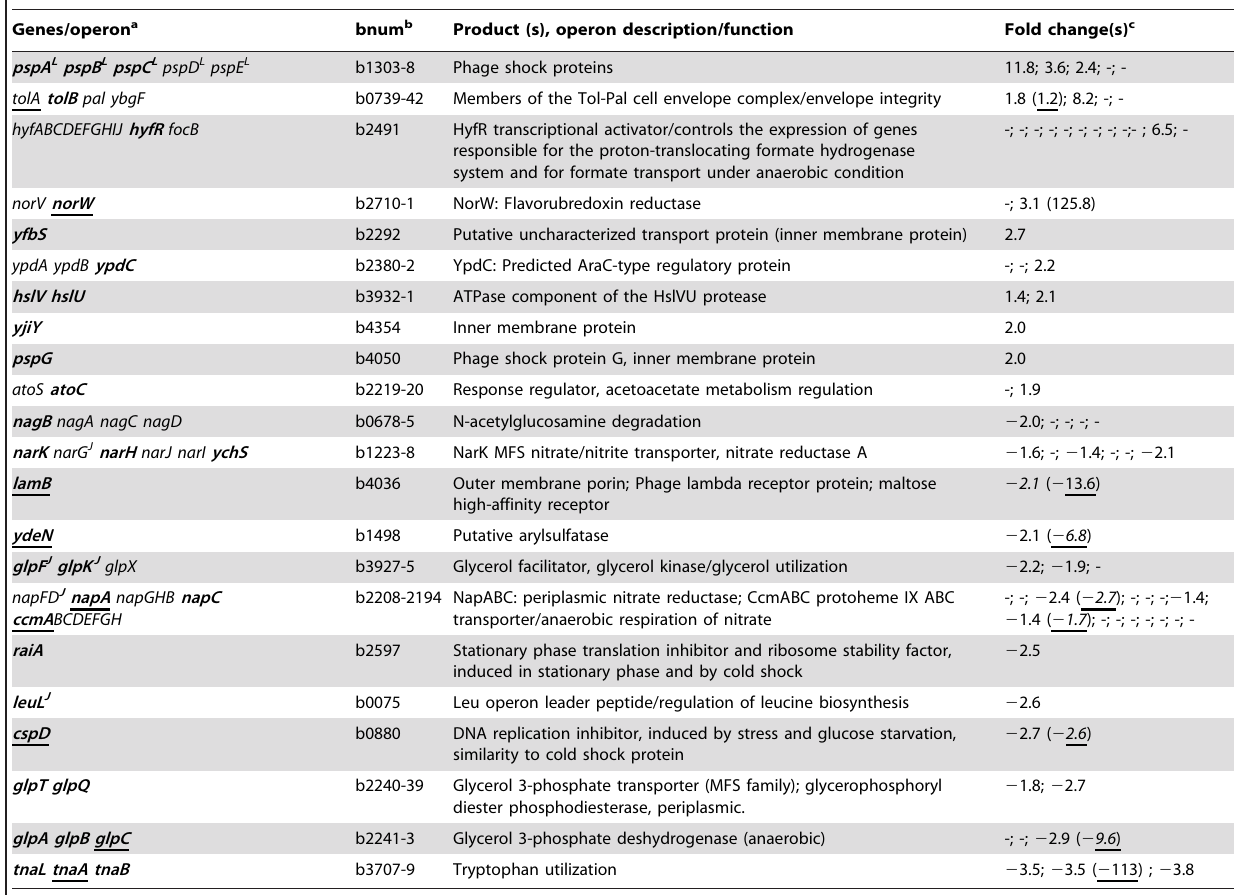
Table 5. Genes whose expression is significantly modulated by